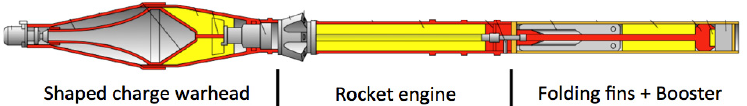
Figure 2. Schematic view of the PG-7 antitank round, consisting of a first part with the warhead and a fixed rocket engine and a second part containing the folding fins and the booster charge, which is screwed onto the base of the first part. The complete round, i.e., with the second part attached containing the folding fins and the booster, is actually designated as PG-7V (and PG-7VM for the complete round with the PG-7M